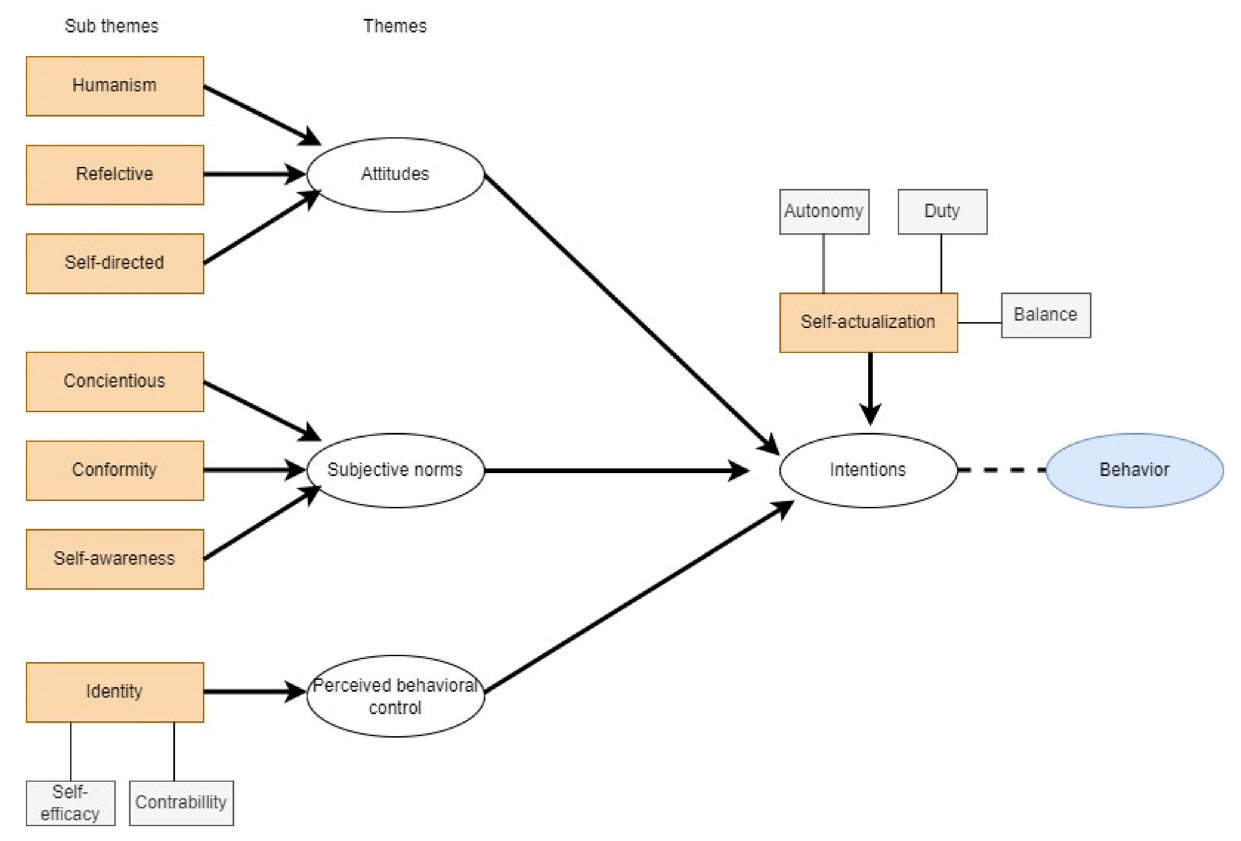
as they exceeded the defined cut point values and validated the findings of our study. We evaluated the path